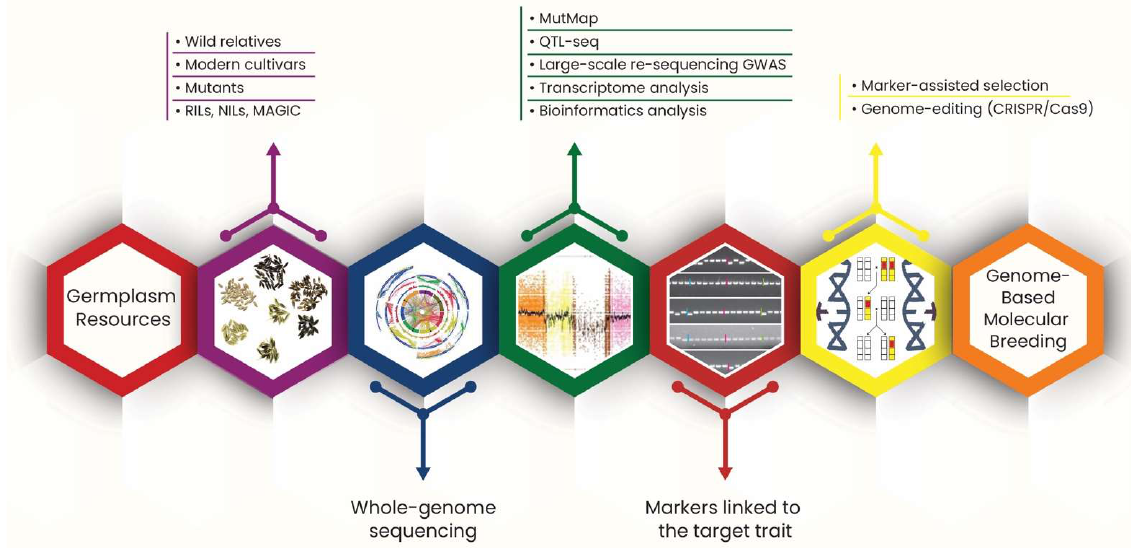
Figure 3. A schematic infographic explaining the process of genome-based molecular breeding.